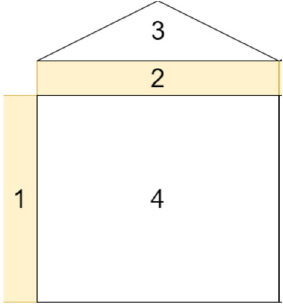
Figure 11. Concept figure of CRAR QFD ‐ LeanDfX.